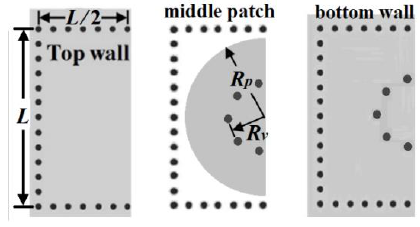
Figure 5. The layouts of the three metal layers for the proposed HMSICR cavity.